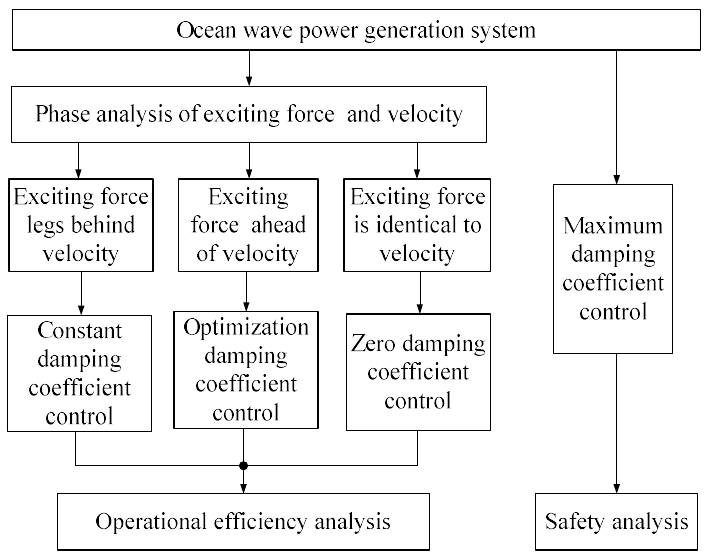
Figure 16. Diagram of damping coefficient optimization control method for ocean wave power generation system.